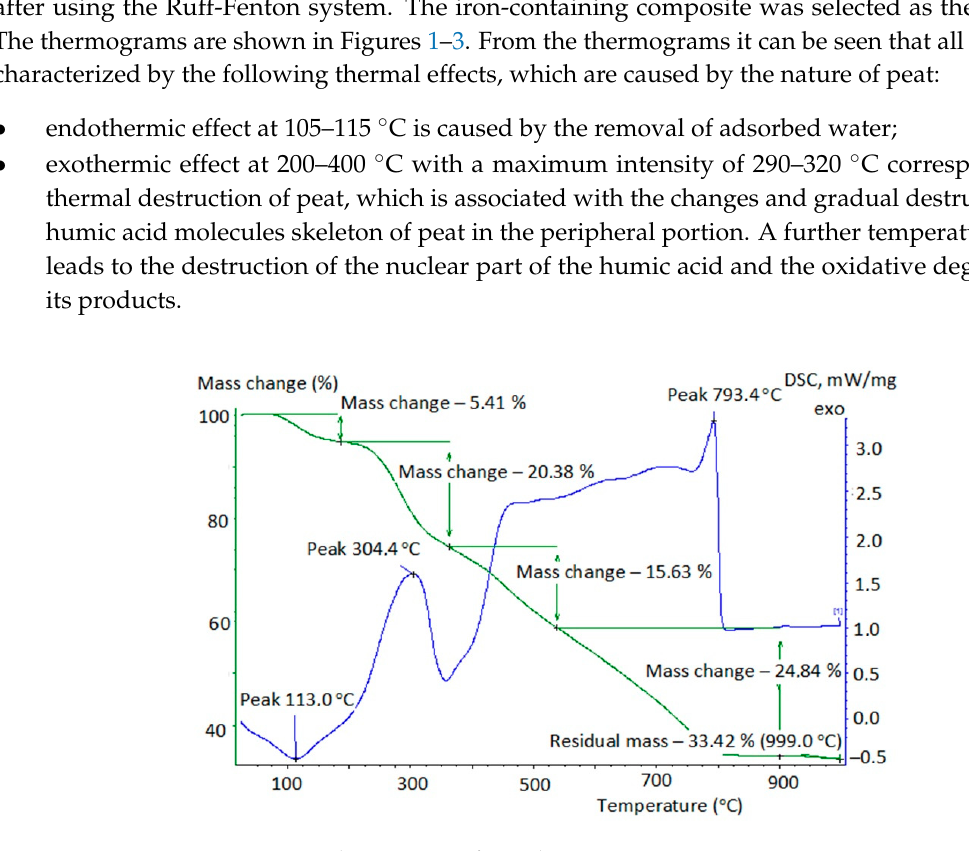
Figure 2. Thermogram of iron-containing peat composite after the sorption of oxalic acid.